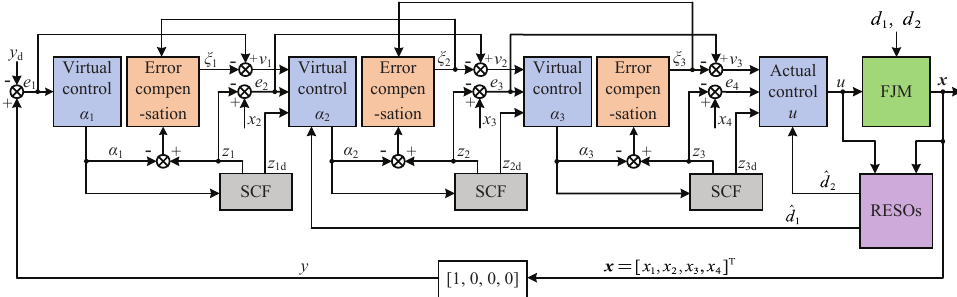
Figure 3. Block diagram of the composite control system for the single–link FJM control